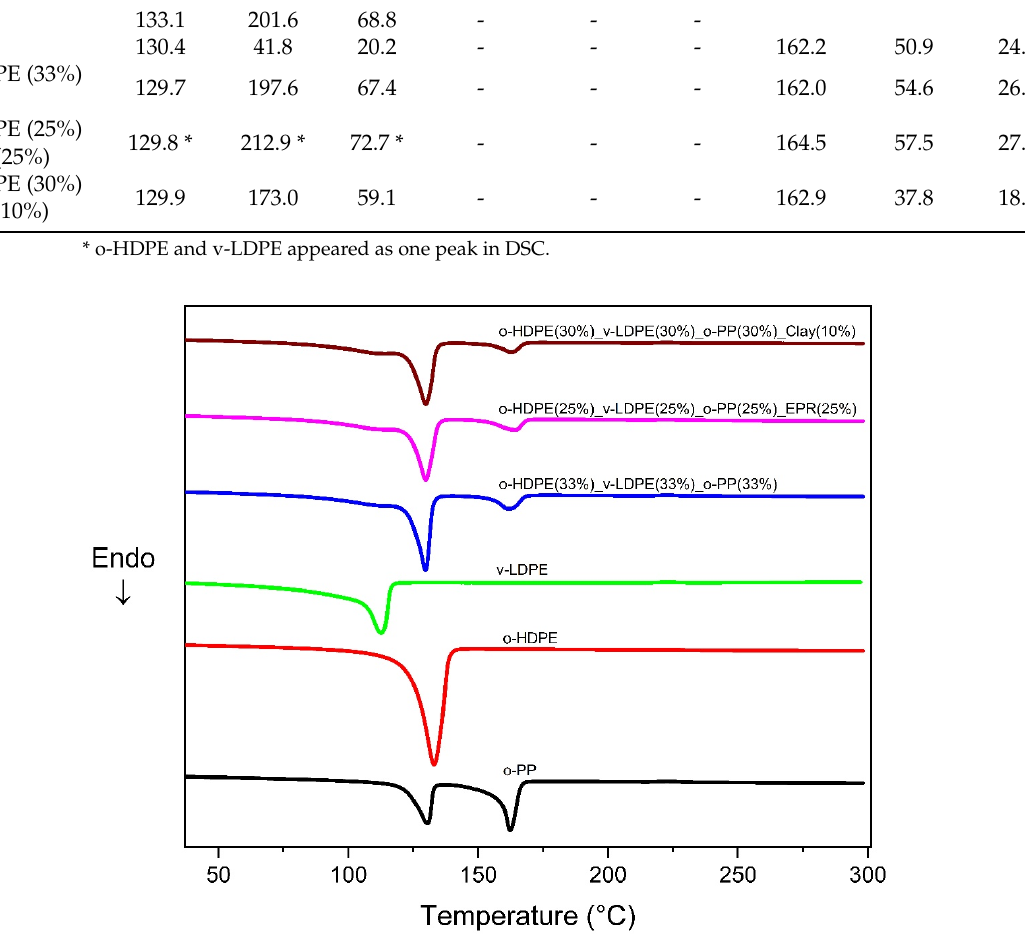
Figure 1. Differential scanning calorimetry of polymer blends composed of o-HDPE, v-LDPE, o-PP, EPR, and clay.